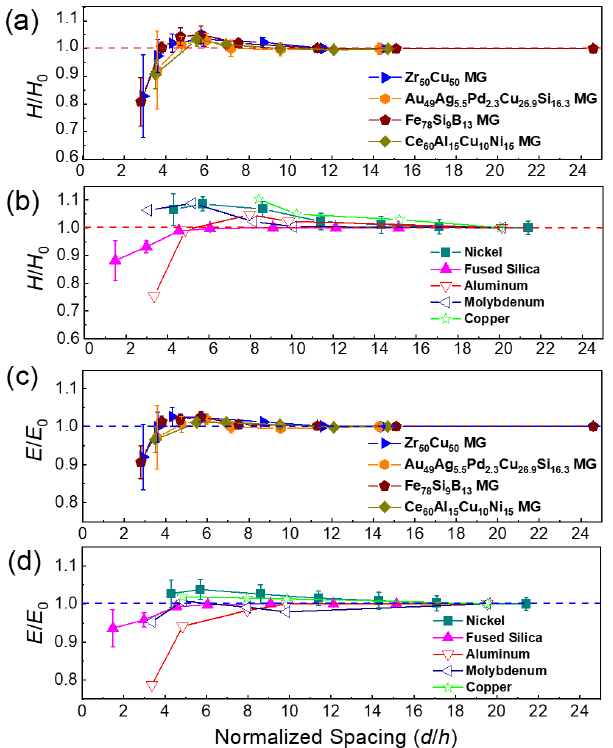
Figure 3. Mechanical properties determined using 2D nanoindentation mapping as a function of normalized spacing ( d / h ) between adjacent indents. The normalized hardness ( H / H 0 ) as a function of d / h for four metallic glass samples ( a ), as well as crystalline metals and fused silica ( b ). The normalized elastic modulus ( E / E 0 ) as a function of d / h for four MG samples ( c ) and crystalline metals ( d ). Each data point in the current study (solid symbols) was obtained by averaging the results of a 6 × 6 array in nanoindentation mapping with a specified d / h , while H 0 and E 0 were the “normal” values obtained with the maximum normalized spacing. The data for aluminum, molybdenum, and copper (open symbols) are from [26]. Table 2. The critical normalized spacing and corresponding changes of the hardness and elastic modulus of the four tested metallic glasses and fused silica relative to the “normal” values obtained with a large normalized spacing ( d / h ≈ 25).